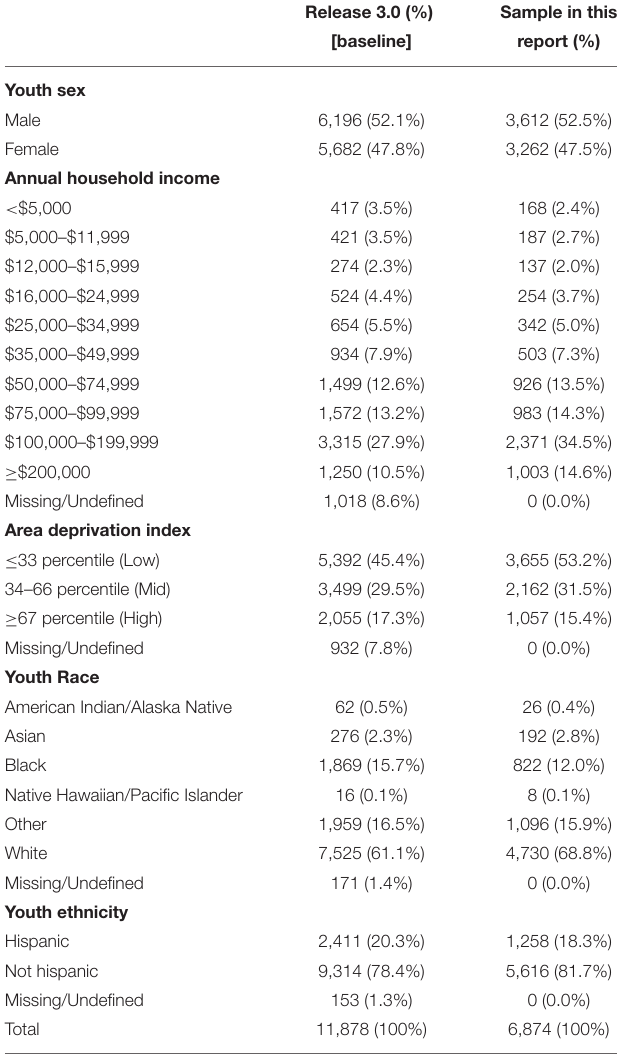
TABLE 1 | Demographics for the Adolescent Brain Cognitive Development (ABCD)